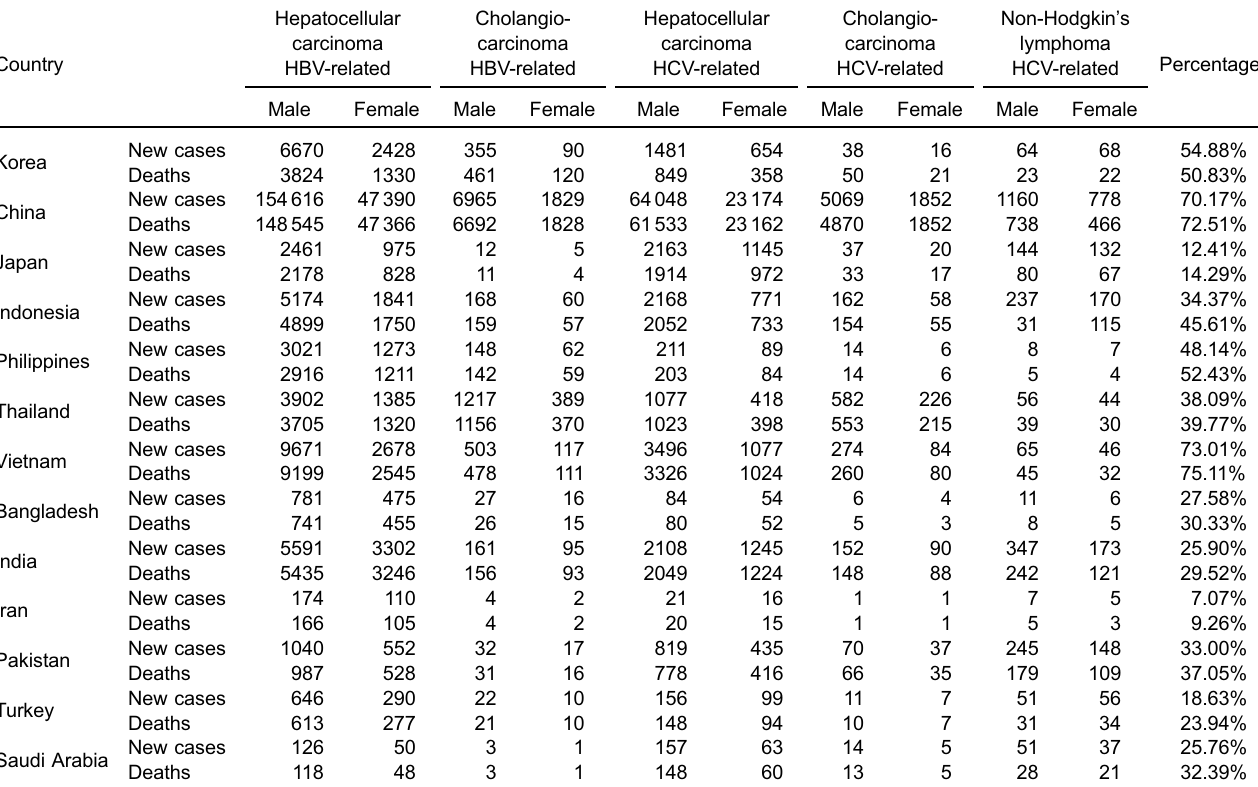
Table 7. Estimated new cancer cases and death caused by HBV and HCV in 2012, by country